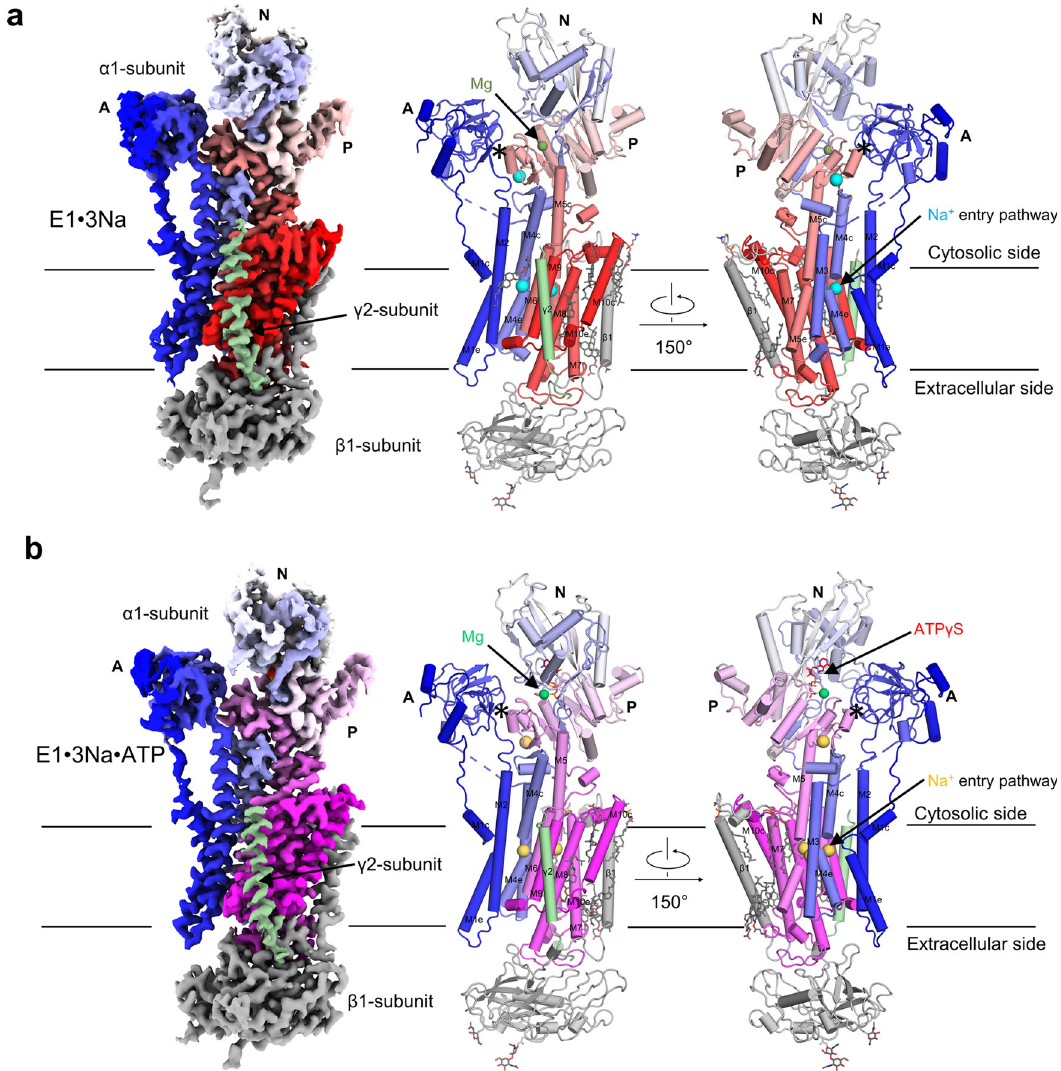
Fig. 1 Overall structures of NKA in the E1·3Na and E1·3Na·ATP states. a The overall cryo-EM map (left panel) and two views of the overall structure (middle and right panel) of the E1·3Na state. The α 1 subunit is rainbow coloured from blue for the N-terminus to red for the C-terminus. β 1 subunit is coloured grey. γ 2 subunit is coloured pale green. b is the same as ( a ) but for the E1·3Na·ATP state (coloured as a spectrum from blue for the N-terminus to magenta for the C-terminus). Na + are coloured cyan or yellow in ( a ) or ( b ), respectively. Mg 2 + are coloured forest green or green in ( a ) or ( b ), respectively. The glycosylation moieties are shown as sticks. e extracellular, c cytosolic, M transmembrane